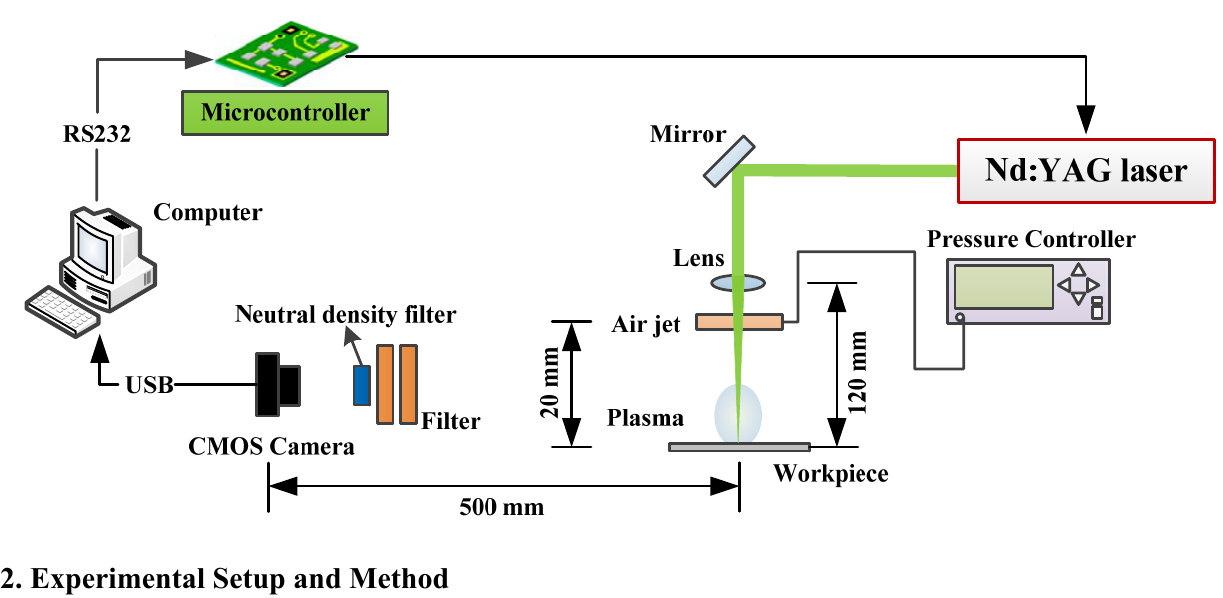
Figure 1. Experimental